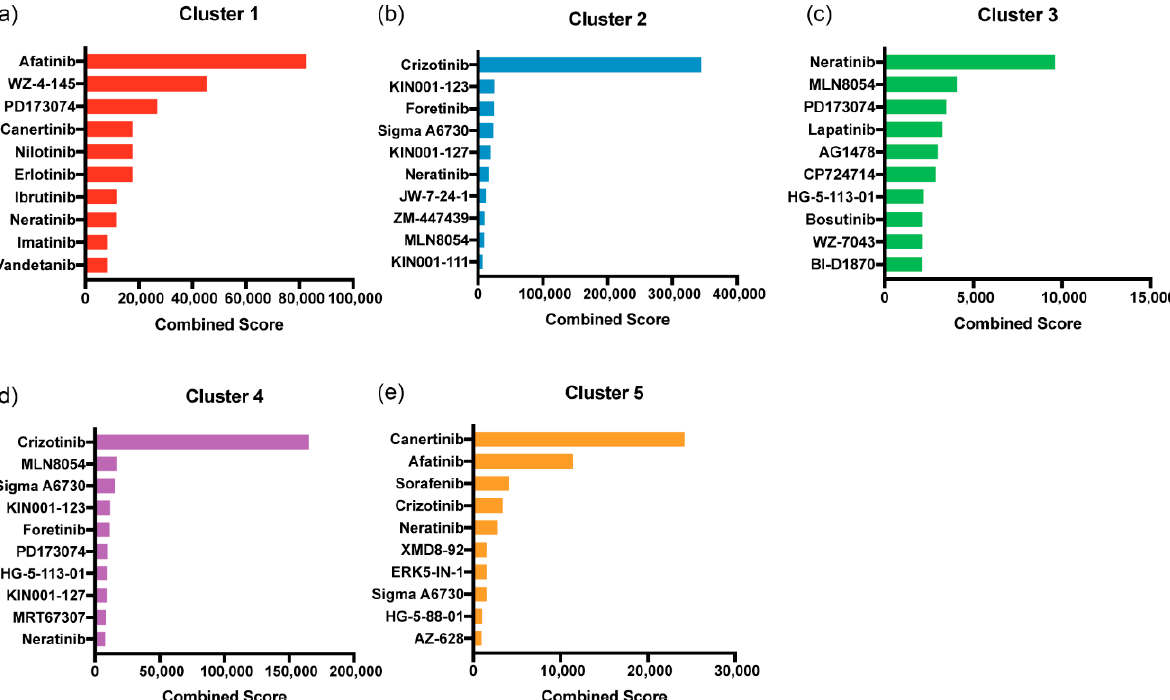
Figure 6. Enriched kinase inhibitors to target the RTK profile in each CCA cluster. The RTK profile of each CCA cluster was queried as gene list in Enrichr using the Harvard Medical School (HMS) KinomeScan Database. The resultant drugs that target the RTKs were filtered for significance ( p < 0.05) and ranked according to the Enrichr combined score (also known as enrichment score) Reprinted from ref. [28]. The top 10 drugs enriched in (a) cluster 1, (b) cluster 2, (c) cluster 3, (d) cluster 4, and (e) cluster 5 are represented in the bar plot. Reprinted from ref.[18].